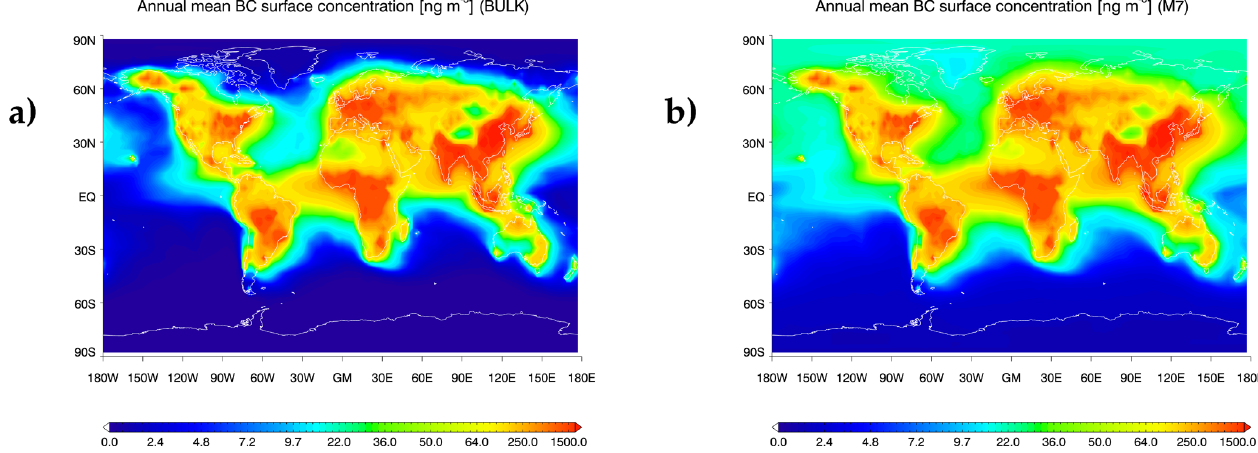
Fig. 1. Annual mean surface concentration of BC [ng m − 3 ] using (a) BULK and (b)